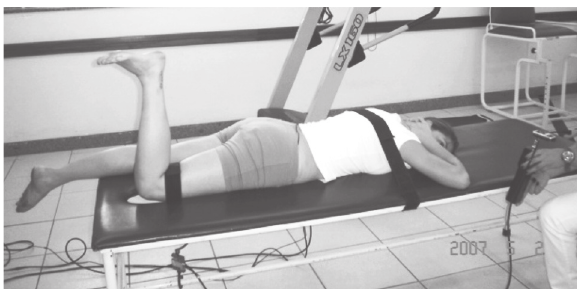
Figura 1 - Contração voluntária máxima, com feedback visual